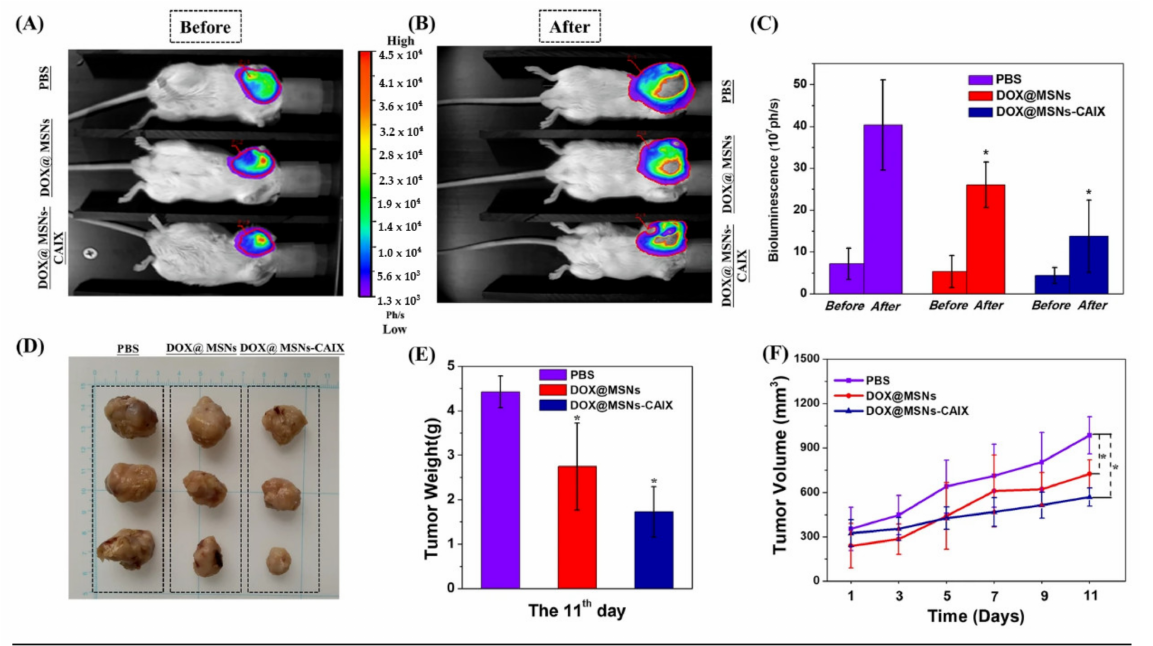
Figure 5. 4T1-Luc tumor-bearing mice treated with different samples (PBS, DOX@MSNs, and DOX@MSNs-CAIX) for 11 days. The tumors’ bioluminescence imaging before ( A ) and after ( B ) in- tervention with the above samples. ( C ) The tumors’ bioluminescence intensity before (the 0th day) and after (the 11th day) intervention with the above samples. ( D ) The tumors’ photographs from the scarified mice. ( E ) The final average tumor weight. ( F ) The variation curves of average tumor volume. (* p < 0.05 as compared with PBS group.) Source: reprinted from Chen, M.; Hu, J.;